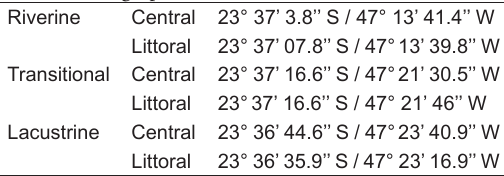
Figure 1. Localization of the Itupararanga reservoir in Brazil, at São Paulo state, High Sorocaba bazin. Detatched the main forming rivers of the reservoir: (1) Una river; (2) Sorocaba Mirim river and (3) Sorocabuçu river. The arrow indicates the dam position in the Table 1. Geographic coordinates.